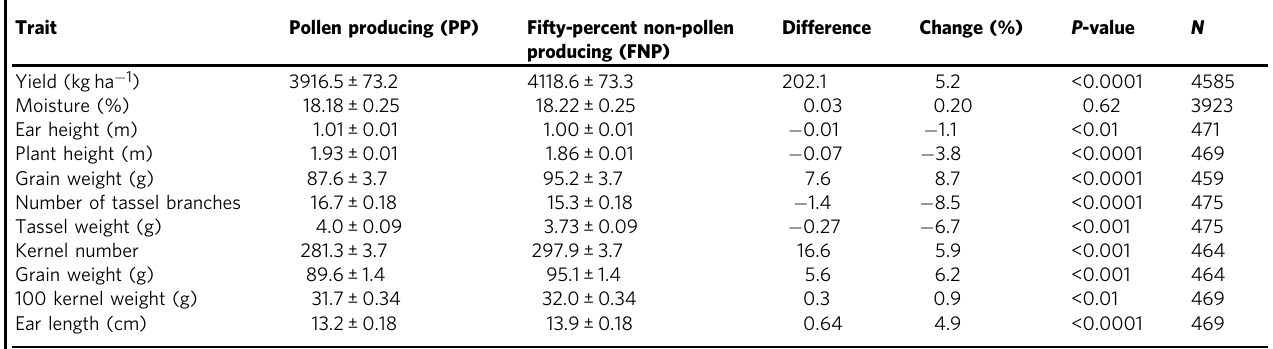
Table 1 Grain yield, yield components, plant and ear height, and tassel traits of 50% non-pollen producing (FNP) and pollen producing (PP) control hybrids.